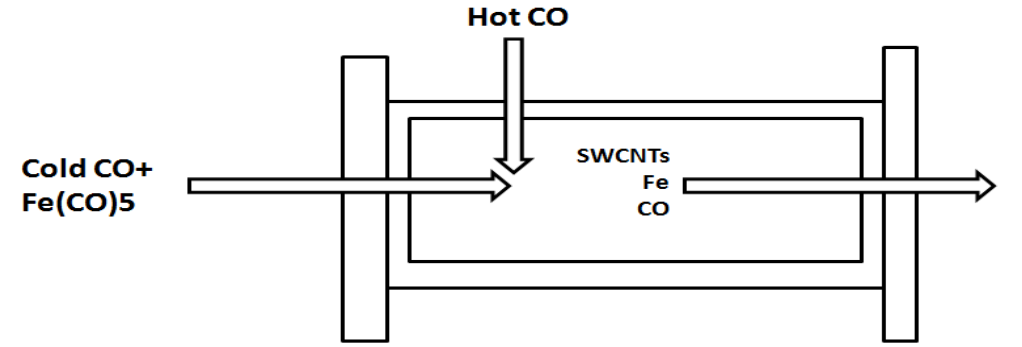
Figure 1. Schematic diagram of the HiPco synthesis